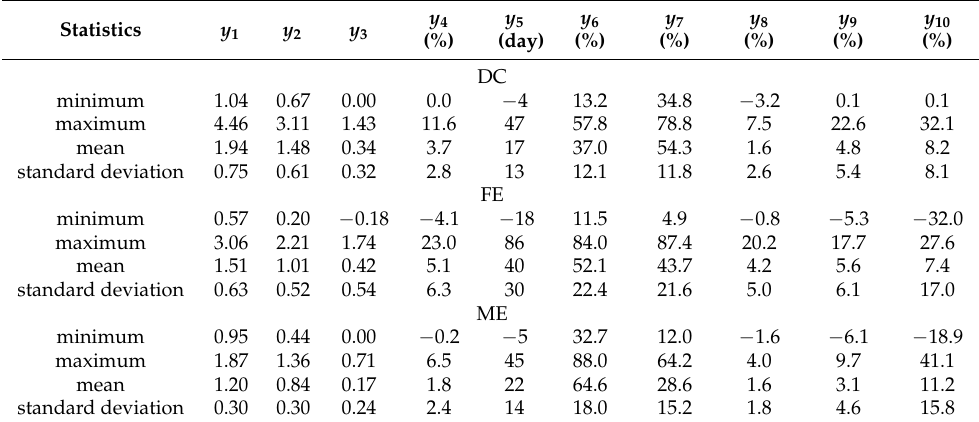
Table 2. Descriptive statistics of the data sample used.